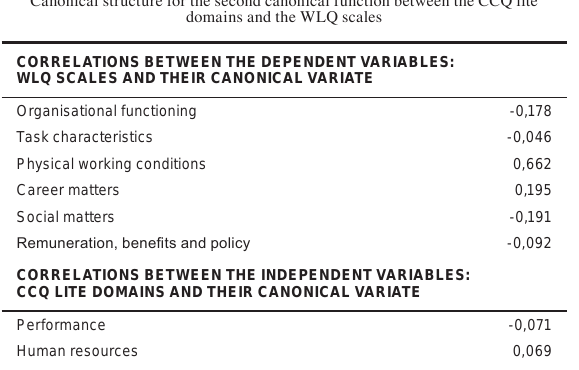
Table 8 Canonical structure for the second canonical function between the CCQ lite domains and the WLQ scales